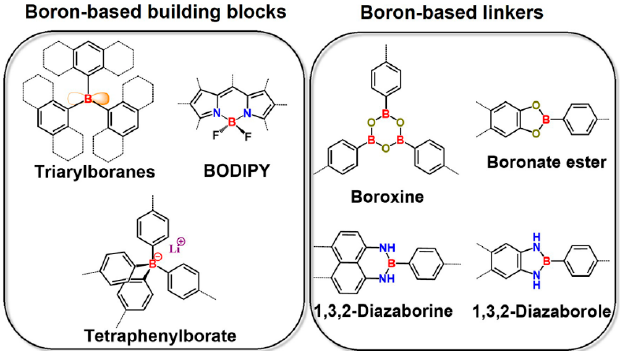
Figure 1. The categories of boron-based building blocks (left) and boron-based linkers (right) used for boron-containing conjugated porous polymers.